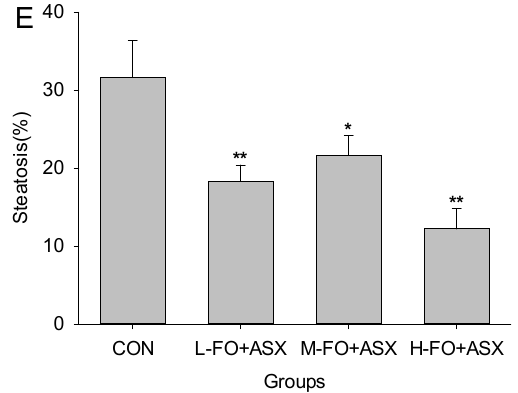
Figure 2. Liver histology after hematoxylin and eosin (H&E) staining of sections from representative rats from each group: ( A ) high ‐ fat diet group; ( B ) low FO and ASX group; ( C ) moderate FO and ASX group and ( D ) high FO and ASX group. Arrow/arrowheads indicate micro ‐ and macrovesicular steatosis, respectively. Asterisks mark scattered foci of macrovesicular steatosis; Volume density quantitation of hepatic steatosis ( E ). Bars represent means ± SEM ( n = 5 animals/group). * p < 0.05 and ** p < 0.01 compared to CON group.